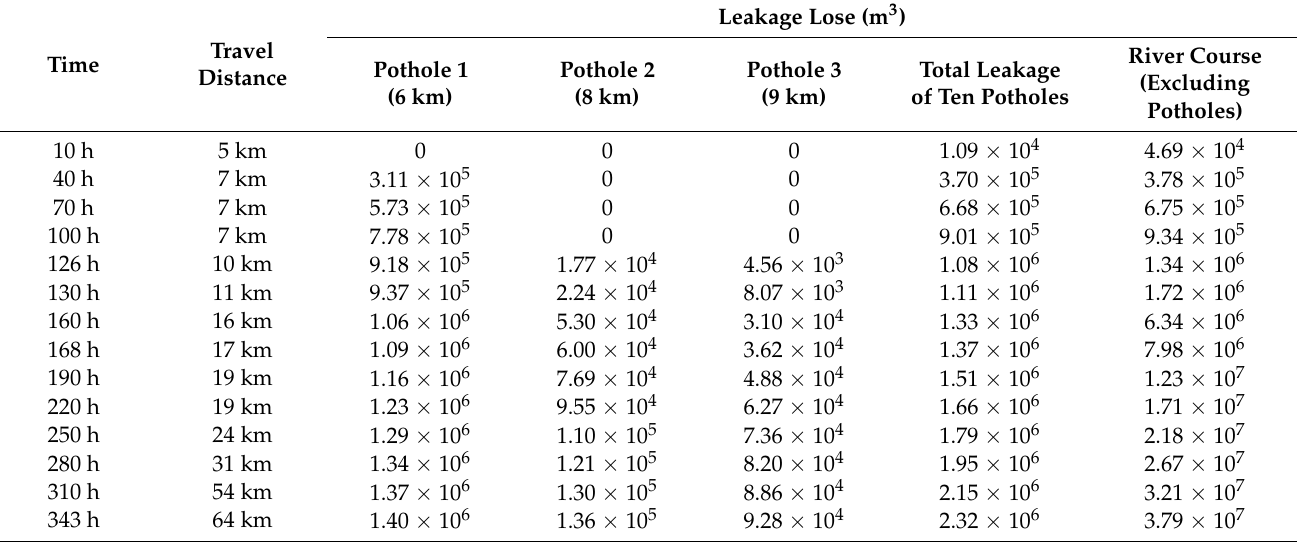
Table 6. Leakage loss over time.